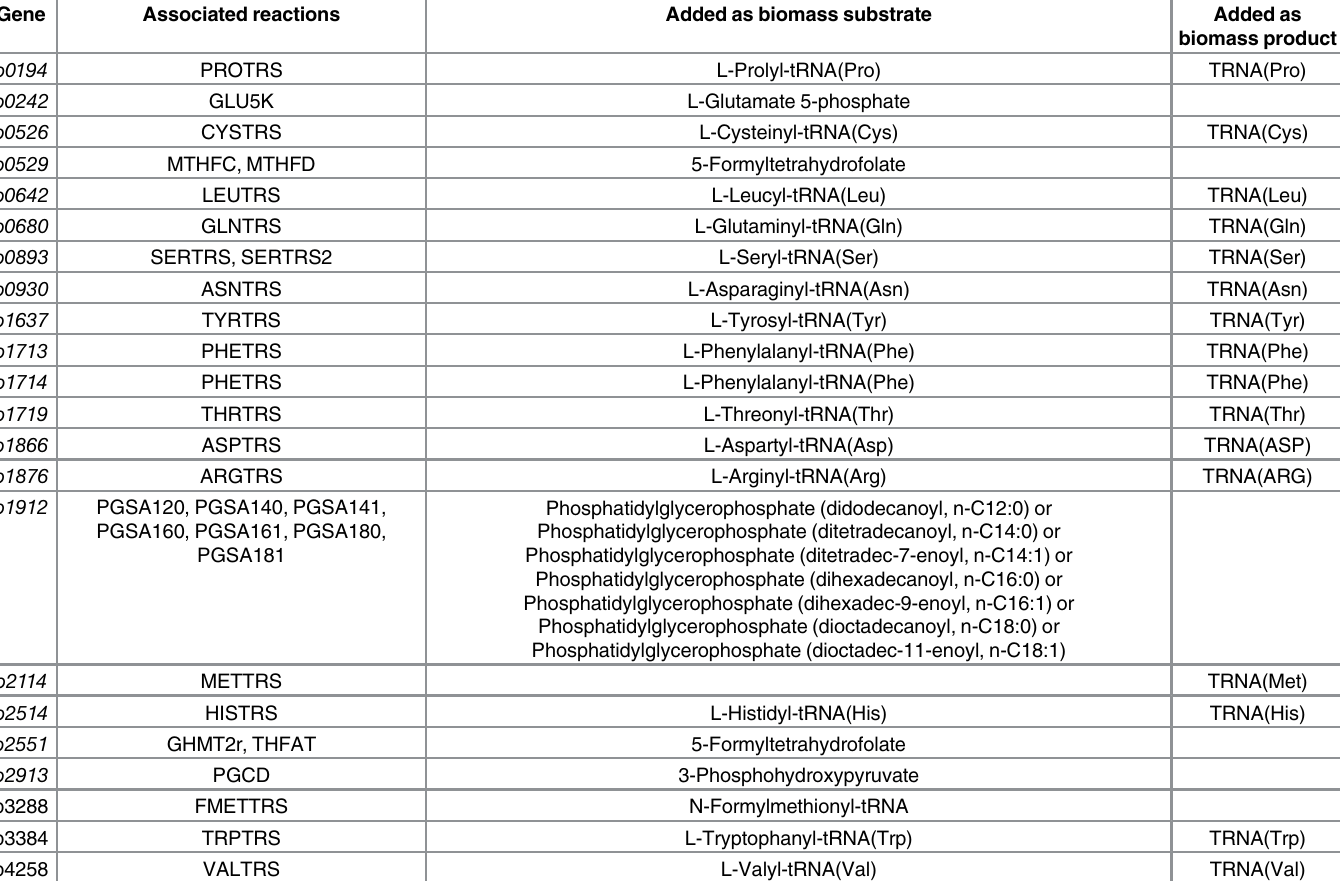
Table 7. Metabolite additions to the E . coli biomass reaction suggested by GlobalFit to resolve FPp. Gene Associated